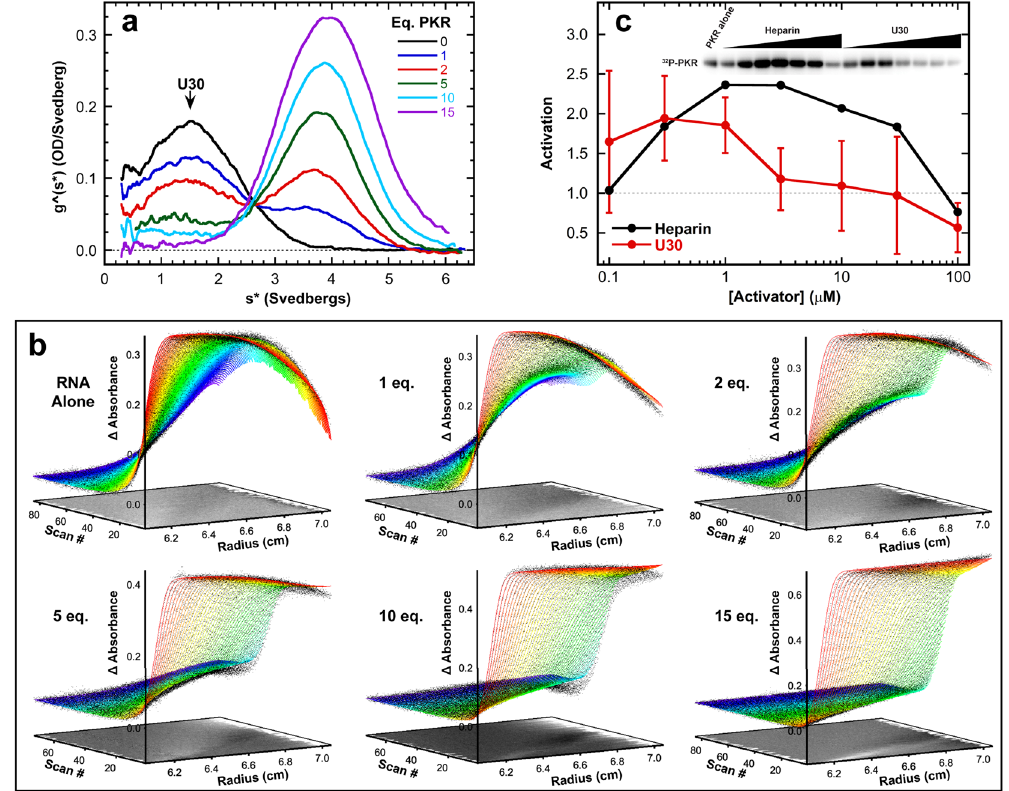
Figure 2. Interaction of PKR with ssRNA. PKR binding to U30 ssRNA was assayed by sedimentation velocity analytical ultracentrifugation. Measurements were performed in AU75 buffer at 20 °C and 50,000 rpm using absorbance detection at 260 nm. ( a ) Titration of U30 with PKR represented as an overlay of g^(s * ) sedimentation coefficient distribution functions. The samples contained 1 µ M U30 ( ) and 1 µ M U30 plus 1 eq. ( ), 2 eq. ( ), 5 eq. ( ), 10 eq. ( ), and 15 eq. PKR ( ). The decrease in the U30 peak and appearance of the peak at higher S are due to complex formation. ( b ) Global analysis of the time difference curves. Scans within each data set were subtracted in pairs to remove time-invariant background noise and fit to a sequential 2:1 binding model using SEDANAL 53 . The data are indicated by points and the fit by solid lines. The residuals are plotted as a grayscale image in the x-y plane at z = 0. The best-fit parameters are in Table 1. ( c ) Activation of PKR by U30. 500 nM PKR was incubated with variable concentrations of U30 in AU75 buffer with 5 mM MgCl 2 for 20 min at 32 °C. Samples were resolved by SDS-PAGE and 32 P-PKR was quantified with a phosphorimager. The data are normalized to activation of PKR in the absence of activator. The error bars correspond to the standard deviation from three replicates. The inset shows a cropped image of the